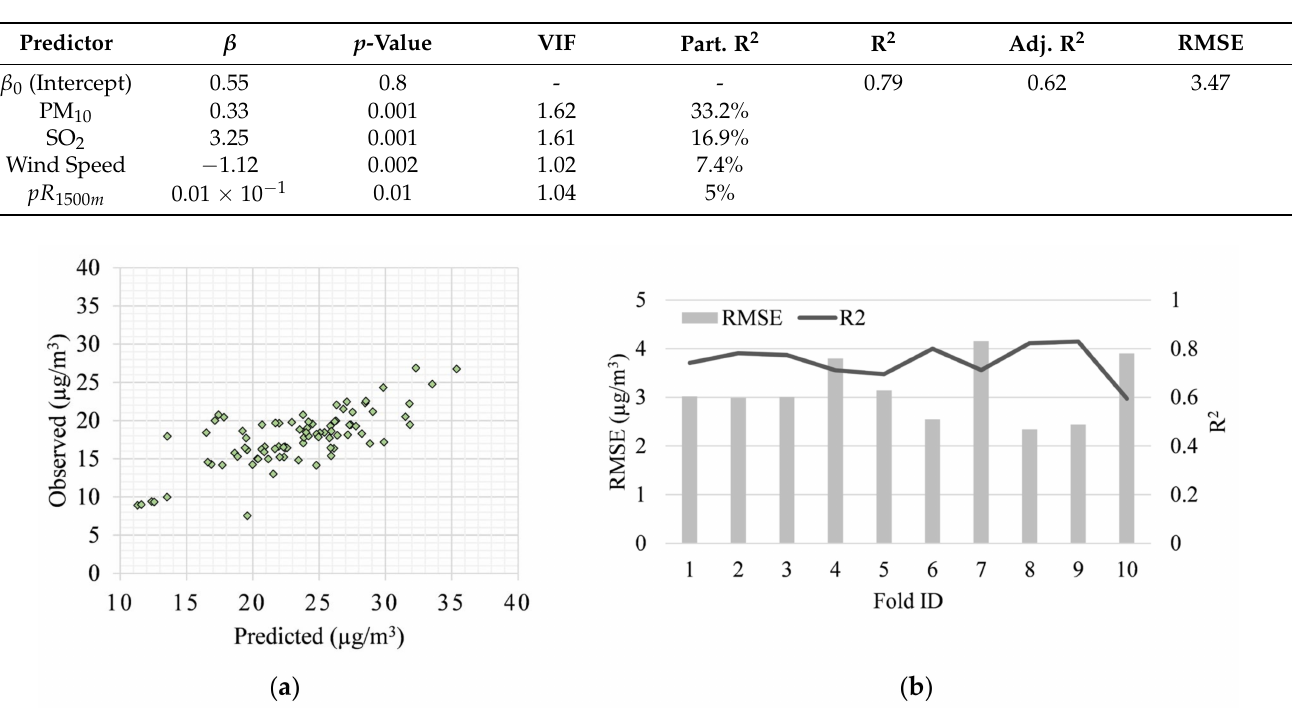
Figure 11. External verification using the PM 2.5 data of the year 2018. ( a ) Observed ( y -axis) and estimated ( x -axis) PM 2.5 concentration from Model A. ( b ) Accuracy assessment using tenfold